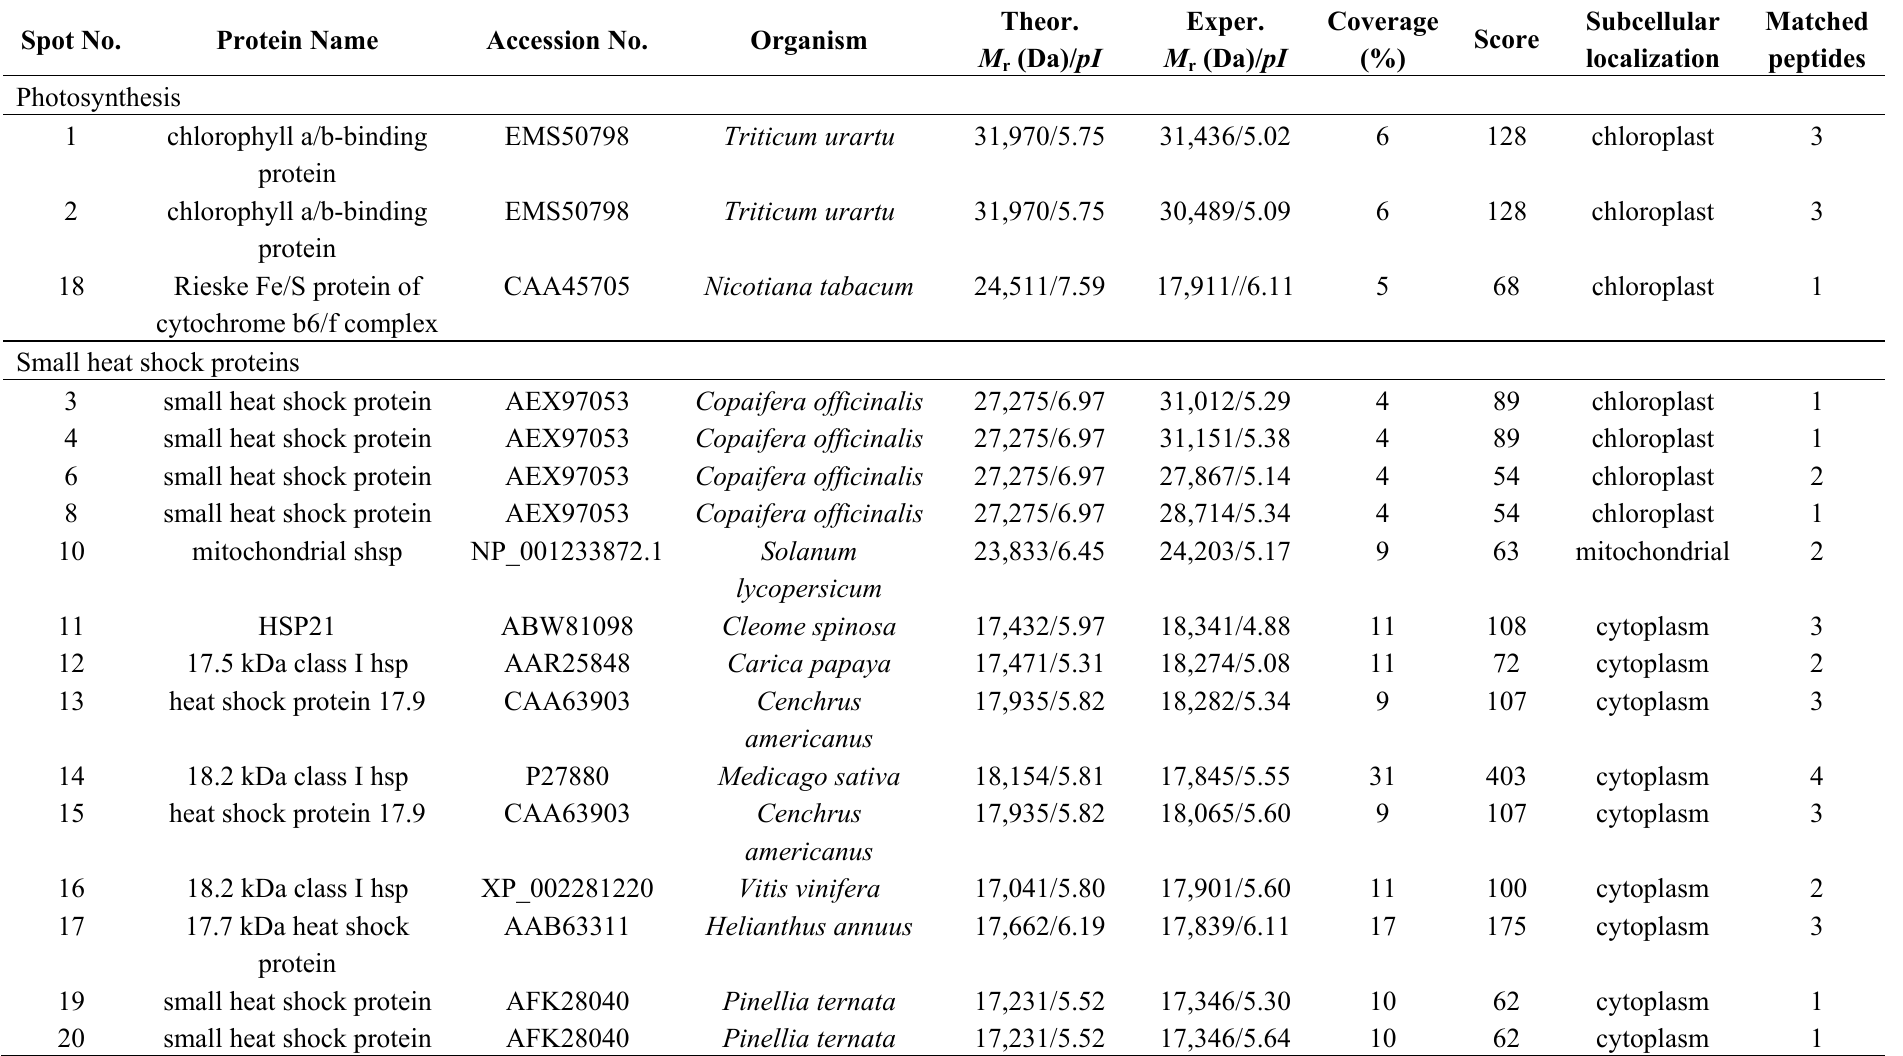
Table 1. MS identification of differentially expressed Proteins in P. ternata leaves exposed to heat stress. Spot